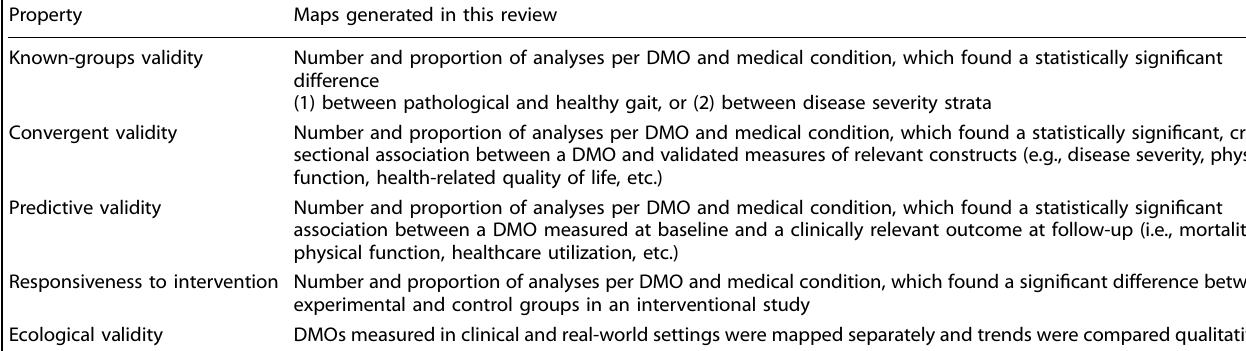
Table 3. Psychometric properties mapped in this review. Property Maps generated in this review Known-groups